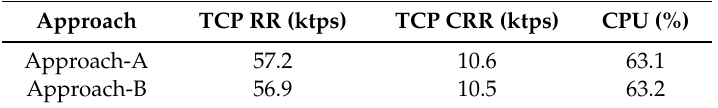
Table 4. The measured number of Netperf TCP_CRR, Netperf TCP_RR and CPU